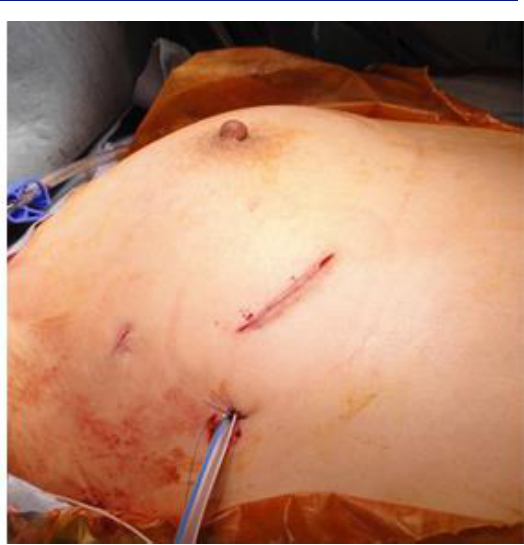
Figure 2: Photo of post mini-thoracotomy after excision of myxoma Standard Median Sternotomy group (SMS group) During induction of anesthesia, the vital signs should be carefully monitored because of hypotension or cardiac arrest due to complete occlusion of cardiac valve. After SMS, CPB was established using aorto- bicavalcannulation, and was